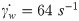
Blood coagulation and thrombus formation in a venous flow (γw˙=64s-1).(a) Snapshots of platelet aggregation at different time instants superposed on the contours of thrombin ([IIa]). Color coding for particles is the same as in Fig 3. (b), (c) and (d) Concentration profiles of thrombin ([IIa]), fibrin ([Ia]) and [ADP], respectively, at three axial positions on the site of injury: x = 157 μm (−−), x = 177 μm (− ⋅ −) and x = 193 μm (—).